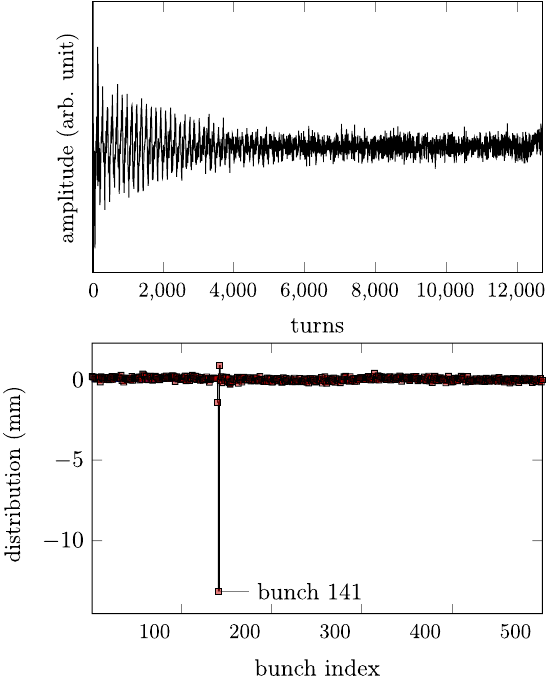
FIG. 9. Temporal vector (top) and spatial vector (bottom) of the energy oscillation extracted from the original data.